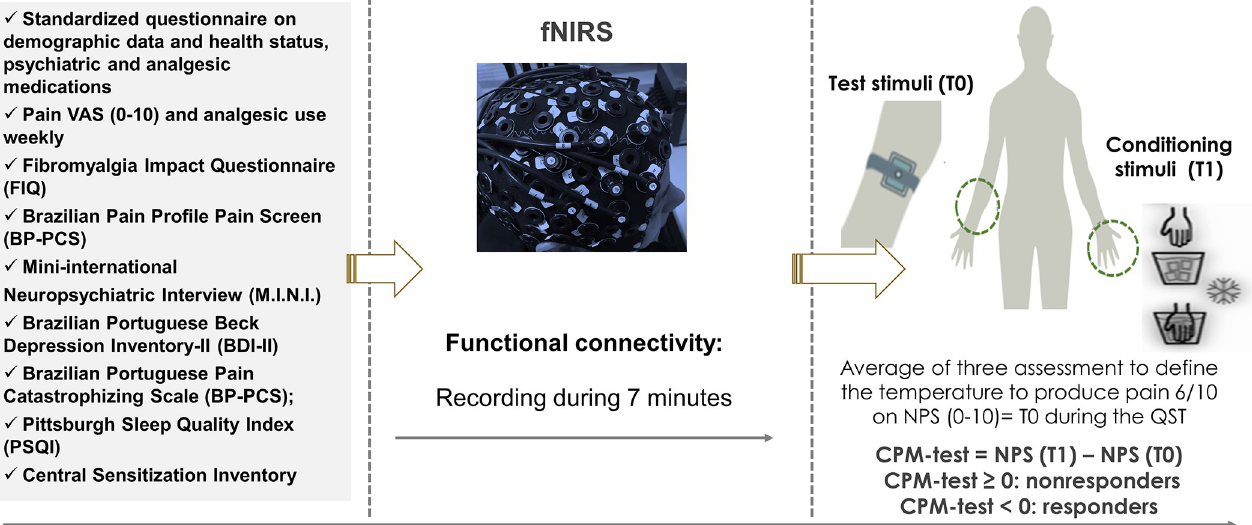
Fig 2. Study flow diagram. Timeline assessments. CPM-test: condition pain modulation test; fNIRS: functional near-infrared spectroscopy. Pain VAS: Pain visual-analog scale. NPS: numeric pain scale. QST: Quantitative Sensory Testing. T0: mean temperature (three measurements per individual) at which the subjects reported a pain score of 6/10 on the NPS (0–10) during the QST before the heterotopic stimulus. T1: temperature equivalent to T0 but applied during hand water cold immersion. NPS(T0): NPS pain score during application of T0. NPS(T1): NPS pain score during application of